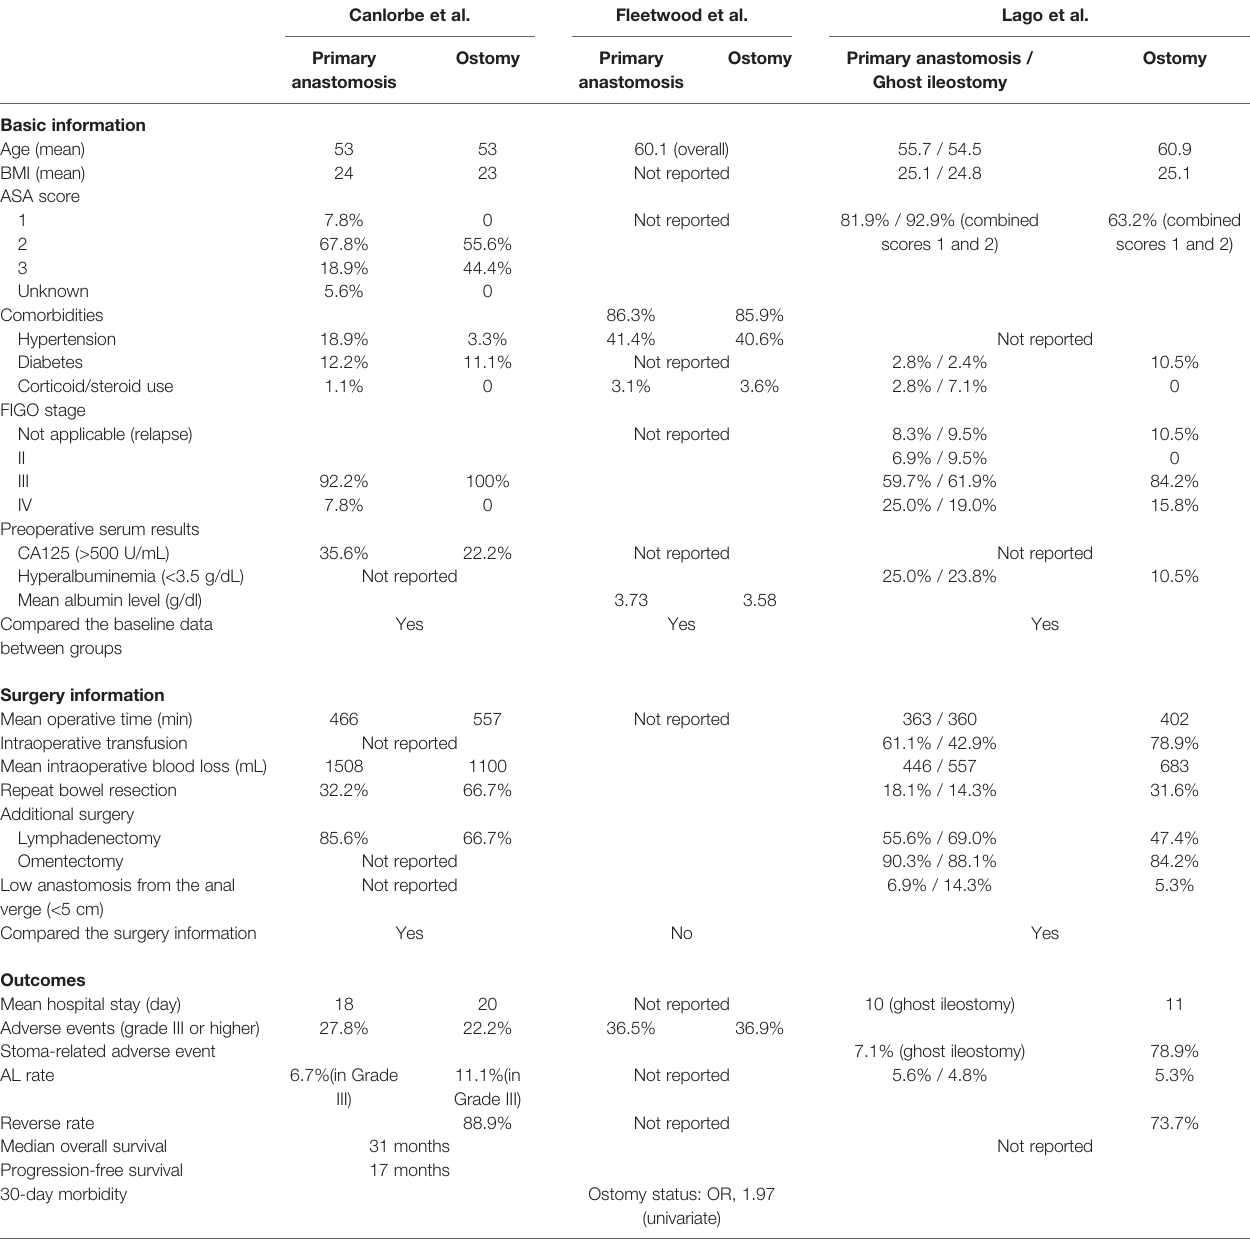
TABLE 1 | Information collected from the three